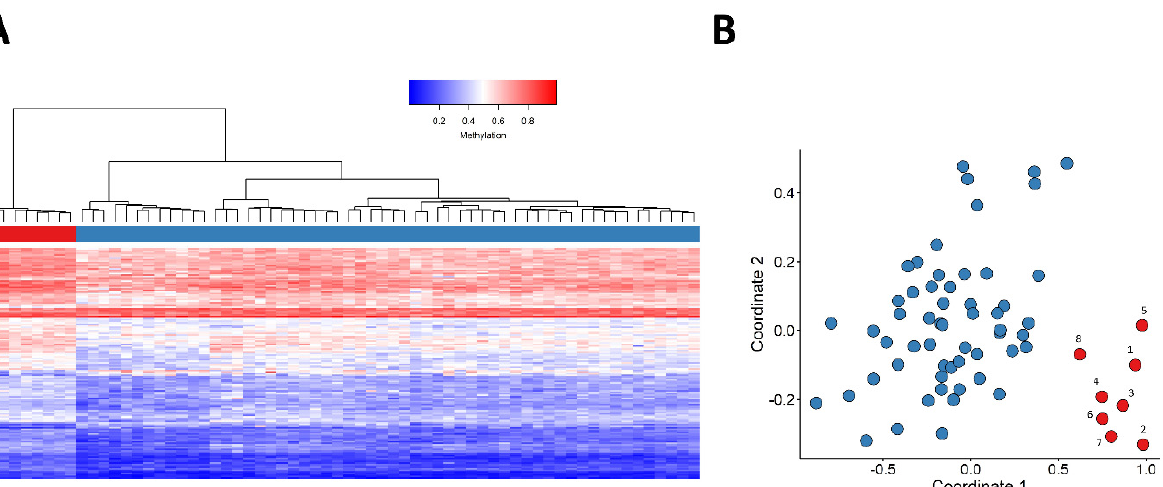
Figure 2. Assessment of the robustness of the JARID2 -neurodevelopmental syndrome episignature in distinguishing between the case and control groups using unsupervised models. ( A ) Hierarchical clustering model, wherein rows represent probes and columns represent individual samples. Patients and control samples are depicted with red and blue, respectively. Heatmap gradient colors scale illustrates methylation levels ranging from blue (no methylation) to red (full methylation). ( B ) Visualization of robust segregation of patients and controls by multidimensional scaling (MDS); X -axis represents coordinate 1 and Y -axis represents coordinate 2 and red and blue circles represent case and control samples, respectively. Patients and control samples (depicted in red and blue, respectively) clearly cluster separately.